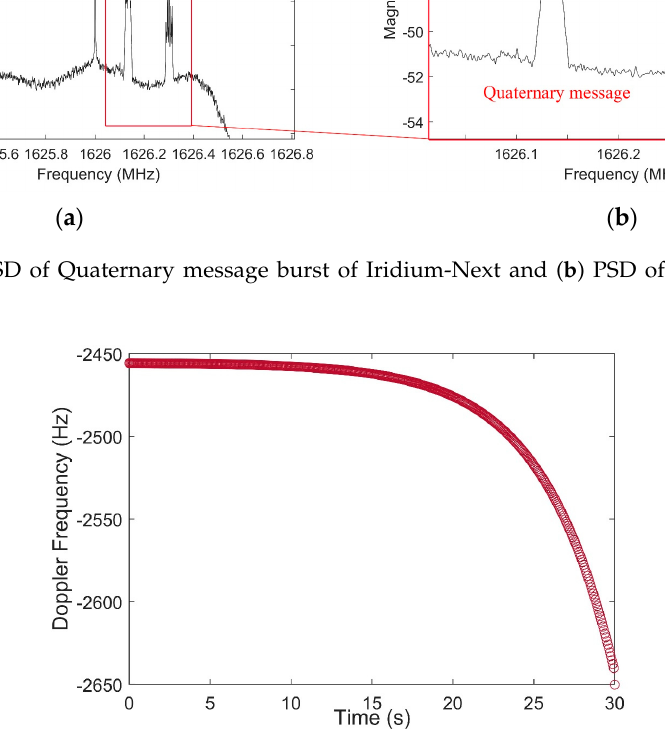
Figure 10. Doppler shift tracking for Orbcomm FM110 in 30 s measurements.